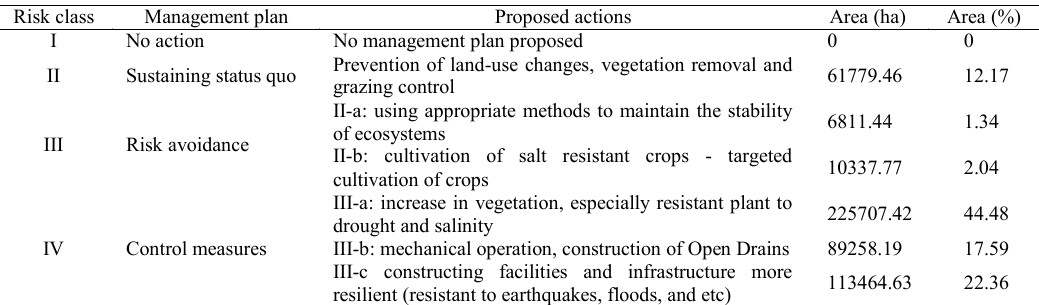
Fig. 6: Desertification risk map of the study area Table 15: Frequency distribution of the surface area of the management plans for the study